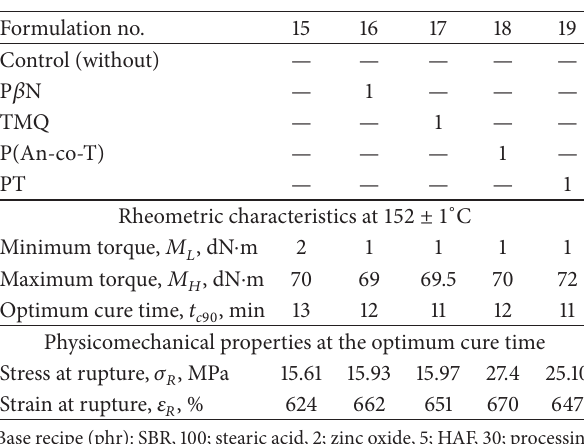
Table 6: SBR Formulations containing prepared P(An-co-T) and PT.